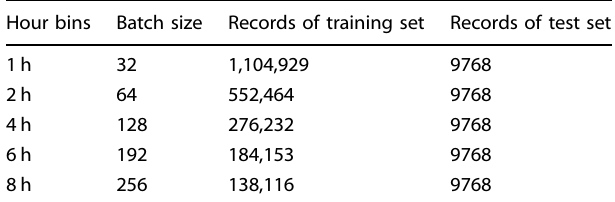
Table 2. Records of different binning